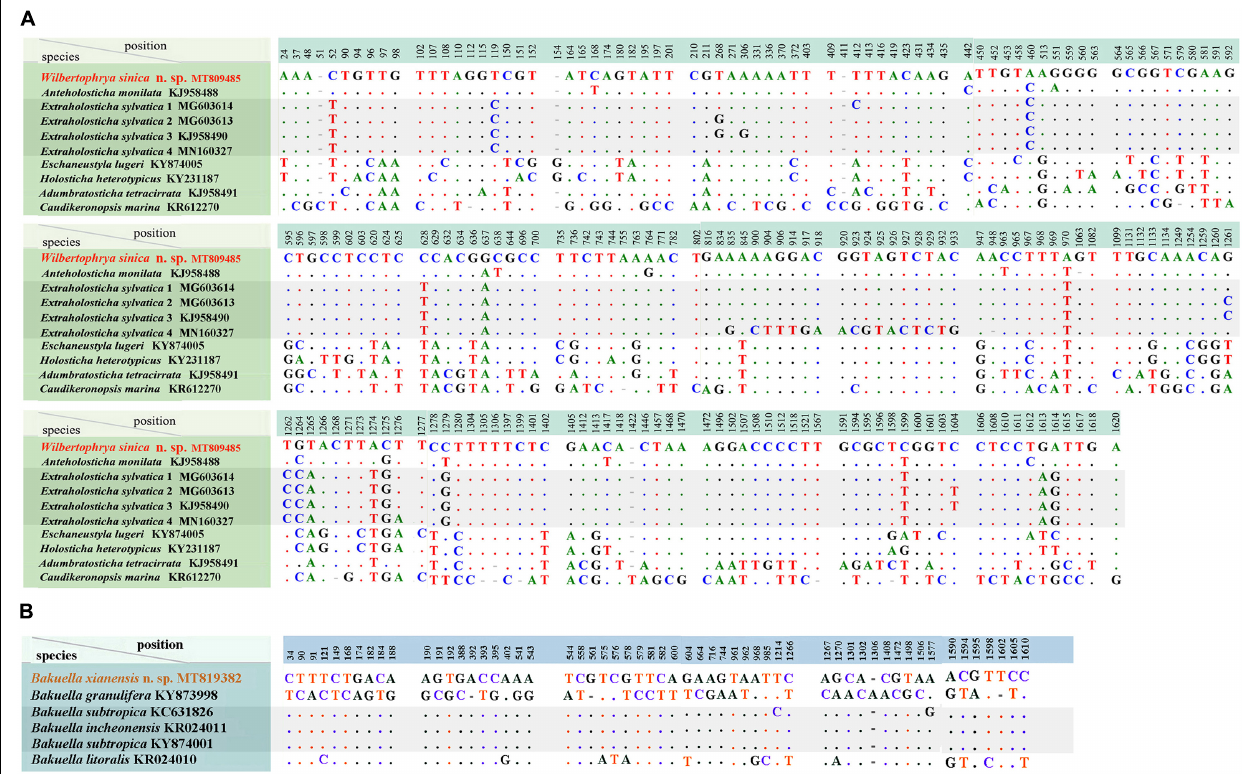
FIGURE 5 | (A) Comparison of small subunit ribosomal DNA (SSU rDNA) sequences showing the unmatched nucleotides between Wilbertophrya sinica n. sp. and related species (for GenBank accession numbers, see Figure 2 ). (B) Comparison of SSU rDNA sequences showing the unmatched nucleotides between Bakuella xianensis n. sp. and related species (for GenBank accession numbers, see Figure 2 ). Nucleotide positions are given at the top of each column. Insertions and deletions are compensated by introducing alignment gaps (-). Matched sites are represented by dots